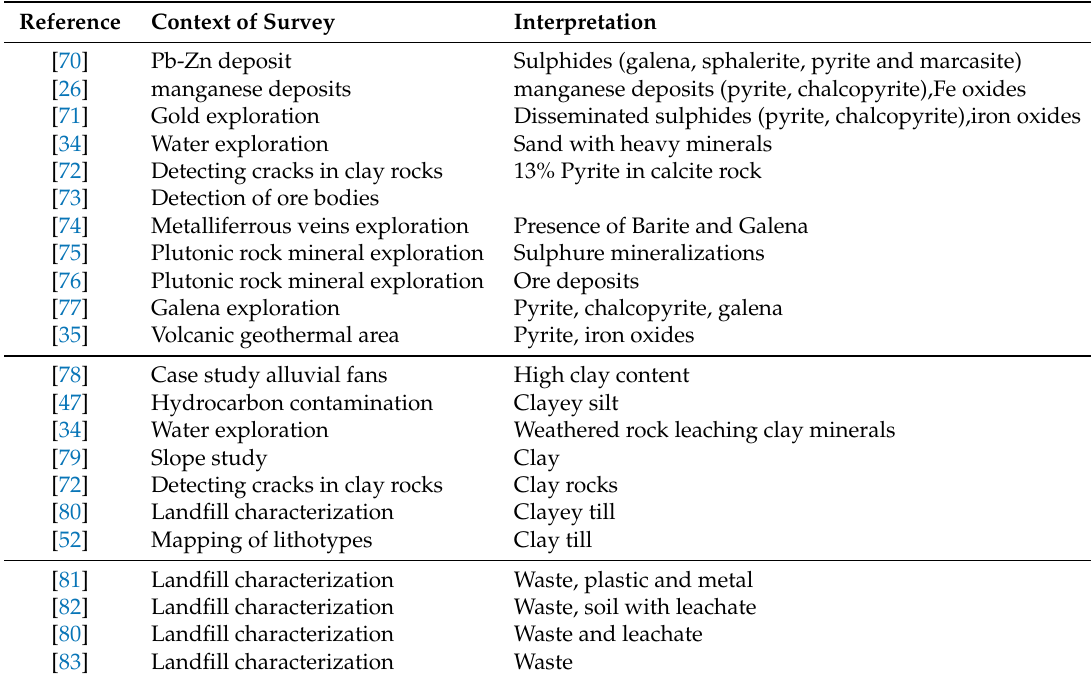
Table 4. Summary of the IP surveys used in Figure 12. Many of those studies did not indicate the signal injection and integration time. For those who did, injection periods range from 1 to 4.4 s and integration times range from 0.6 to 3.6